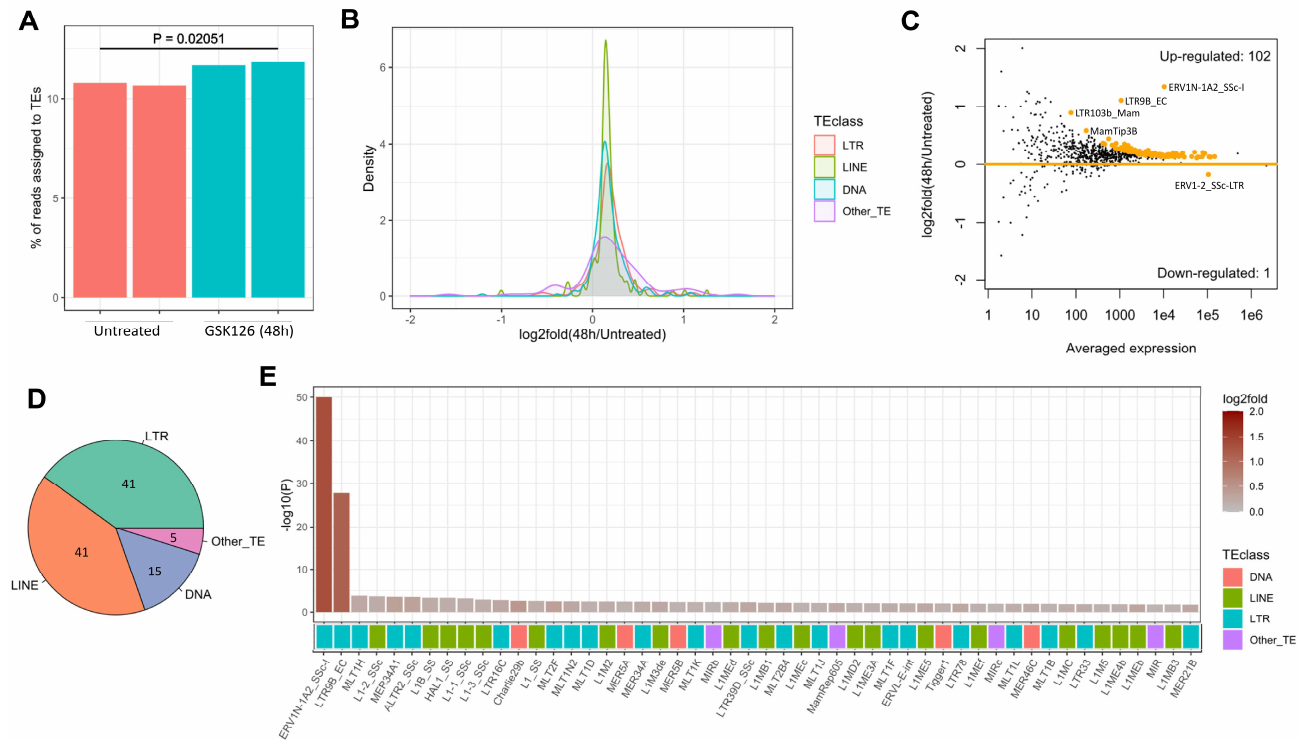
Figure 4. Global derepression of transposable elements in porcine 3D4 cells after EZH2 inhibition. ( A ) Percentages of reads assigned to TEs in 3D4 cells with or without GSK126 treatment (48 h). p-value calculated by using two-sided Student’s test is indicated. ( B ) Density plots compare the altered expression of different classes of TEs, including LTR, LINE, and DNA. ( C ) MA plot shows the altered expression of specific TE families after EZH2 inhibition. TE families with significantly altered expression (P < 0.05) are highlighted in orange color. ( D ) Pie chart shows the proportions of significantly upregulated TE families that belong to each TE class. ( E ) Barplot shows the top 50 significantly upregulated TE families. The color gradient indicates the log2fold expression after EZH2 inhibition (48 h). The y -axis indicates the –log10(P). The colored bars at the bottom indicate the memberships of each TE family in the major TE classes, including DNA, LINE, and LTR.